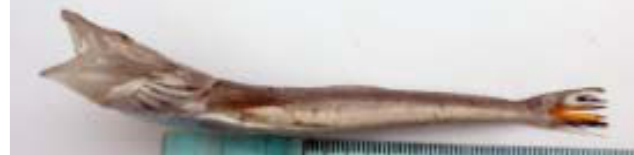
Image 24. Bar-tailed Flathead Platycephalus indicus